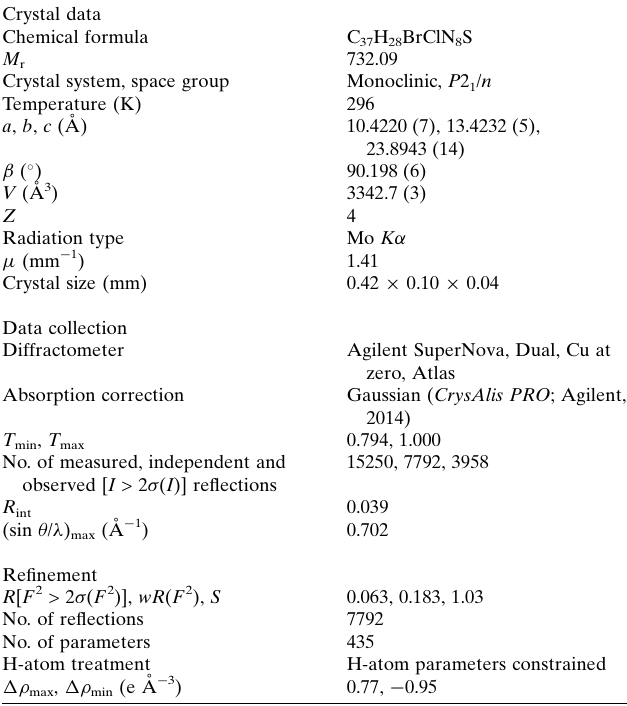
Table 2 Experimental details. Crystal data Chemical formula